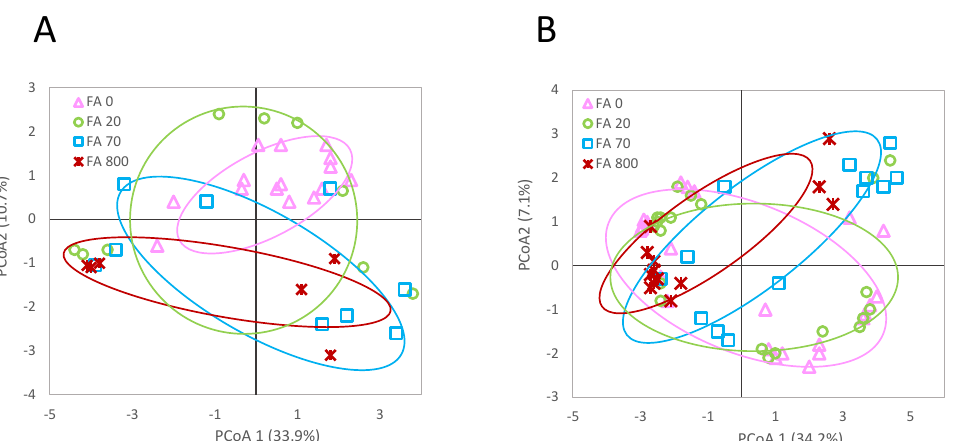
Figure 5. Principal Coordinate Analysis of the detected methylation ( A ) and genetic polymorphism ( B ) site patterns at the sequence 5 ′ -CCGG-3 ′ for L. rubellus exposed for 308 days to a control and 20.8, 70, and 800 mg/kg per dry weight soil fluoranthene throughout development from early juvenile